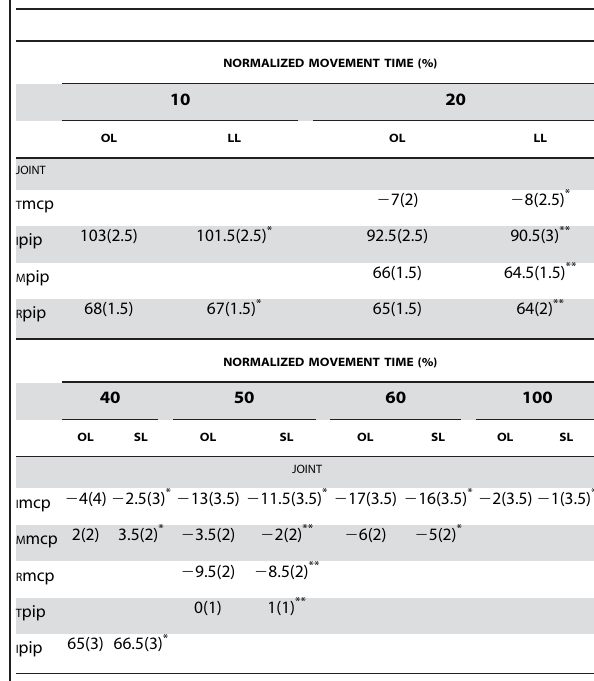
Table 1. Average angular excursions at different epochs of normalized movement